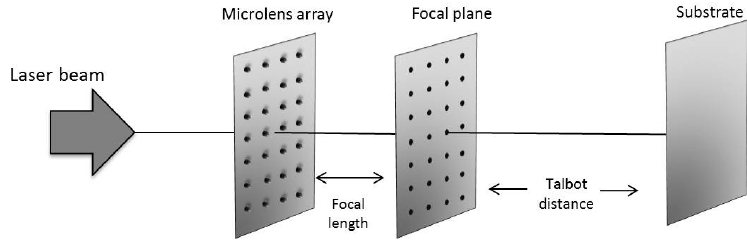
Figure 4. SEM images of the tantalum substrate ( a ) before and ( b ) after being polished. The roughness value decreased from 565.71 nm to 7.81 nm.